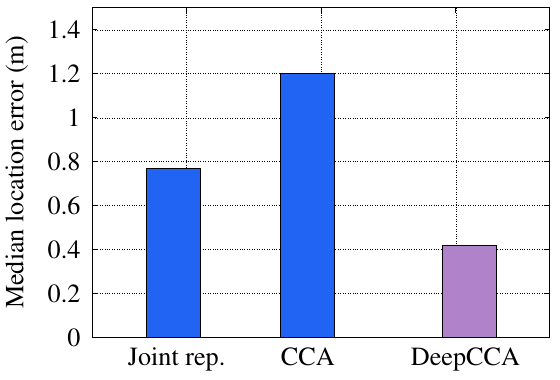
Figure 9. Effect of feature extraction module on RRLoc